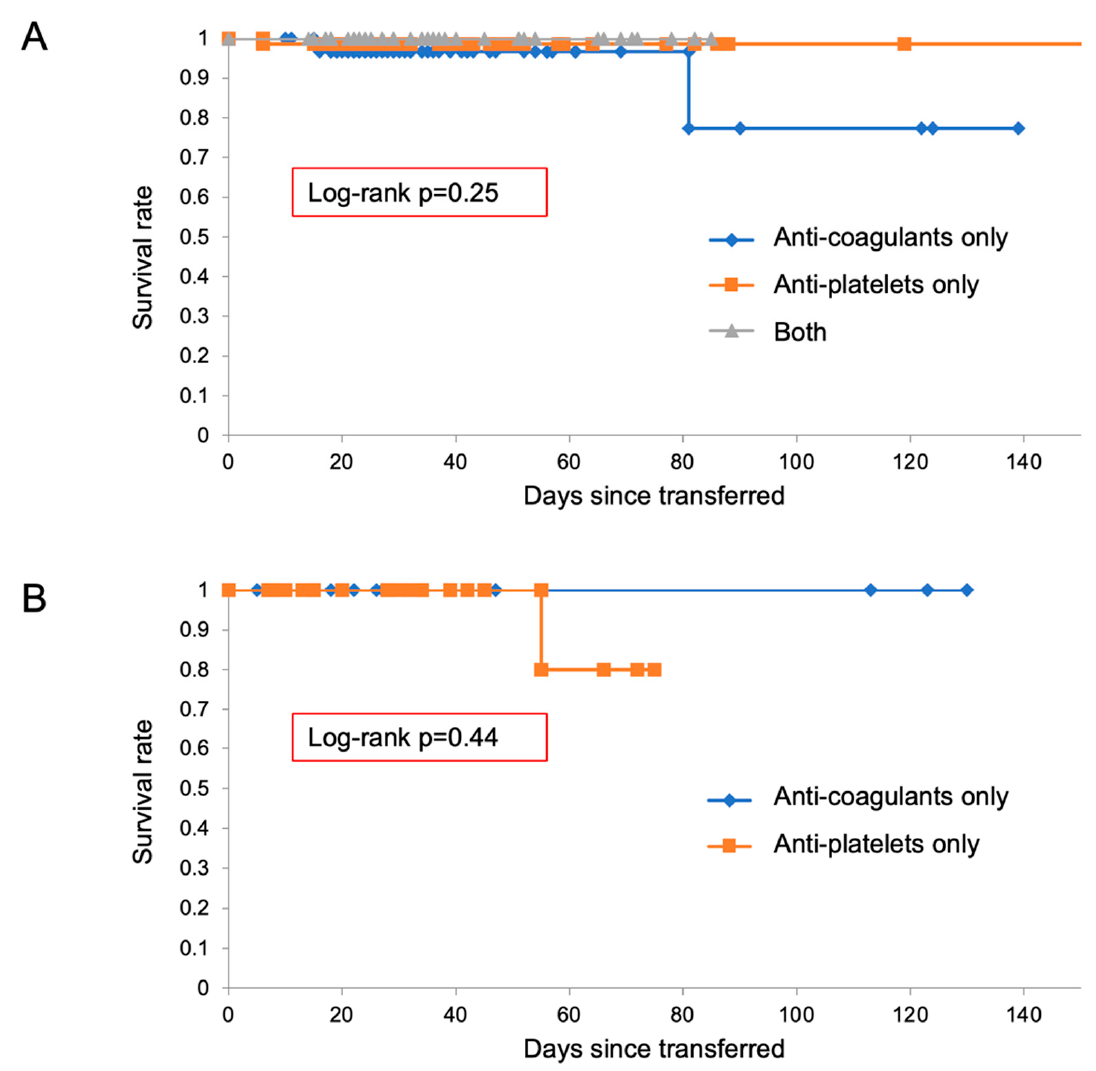
Figure 6. Kaplan–Meier curves of transferred patients receiving “anti-coagulants”, “anti-platelet drugs”, and “both of them”, in type A (panel ( A )) and type B (panel ( B )).